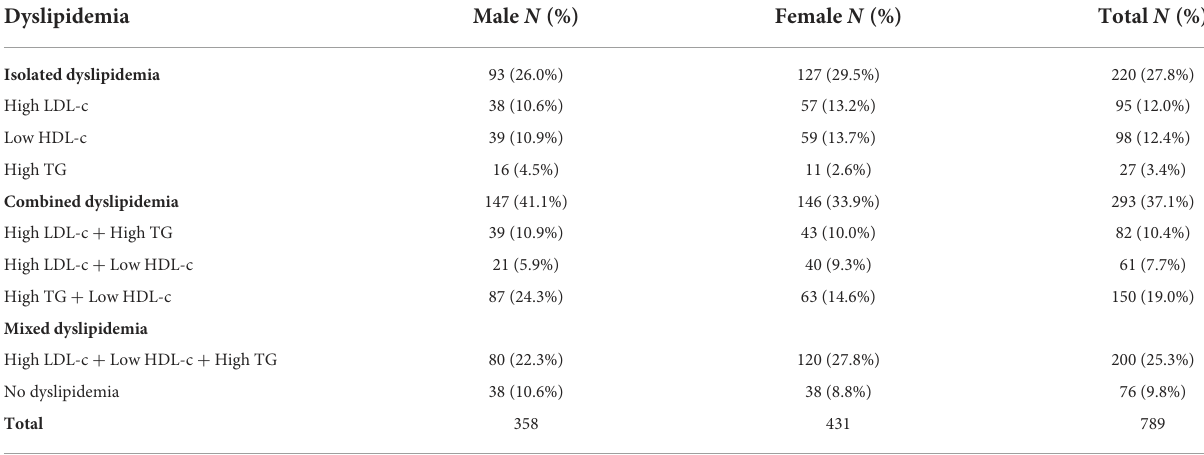
TABLE 2 Prevalence of different patterns of dyslipidemia among patients with type 2 diabetes, Jordan, 2021 ( N = 789). Dyslipidemia Male N (%) Female N (%) Total N (%) Isolated dyslipidemia 93 (26.0%) High LDL-c Low